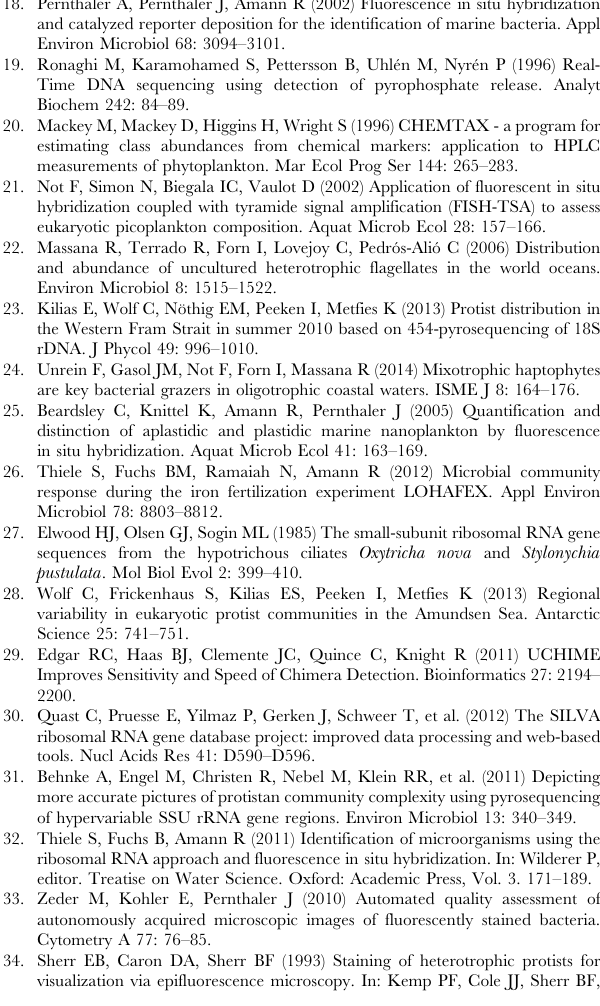
Table S1 Summary statistics of pyrosequencing reads. The table also contains values after quality filtering and number of OTUs of the 0.2–5 m m size fraction. Table S2 Total cell numbers. Results of the quantification